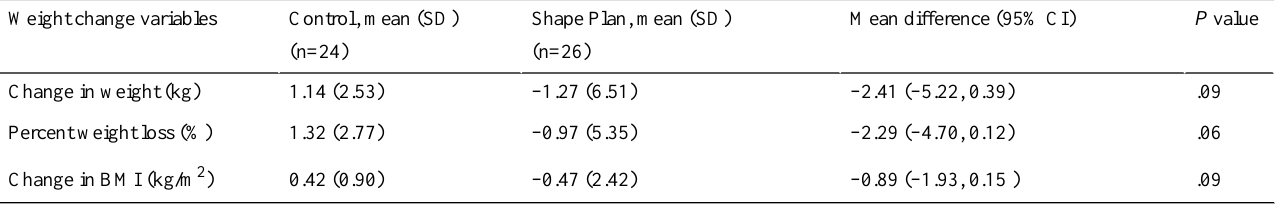
Table 2. Change in weight and body mass index (BMI) between baseline and 6 months by study group